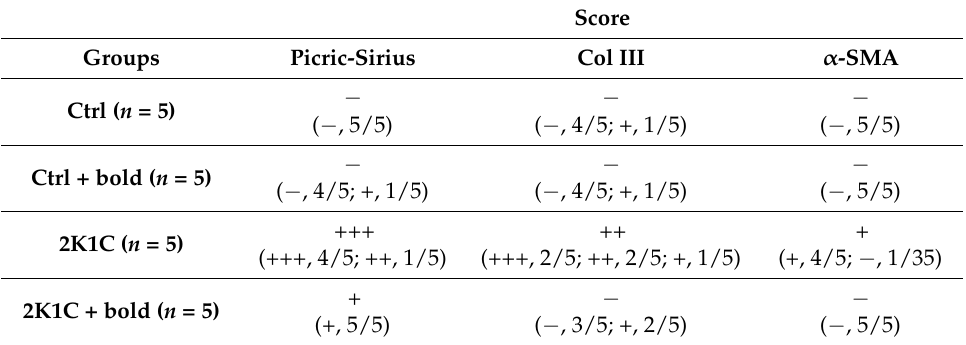
Table 2. Immunoreactivity score for Picric-Sirius, α -SMA, and Col III from tissue samples from rats of the four experimental groups. The semi-quantitative morphometric analysis for Picric-Sirius, α -SMA, and Col III was performed on a scale of negative to three crosses ( − to +++), defined according to the degree of immunoreactivity observed in the renal tissue sample ([ − ] = 0–10%, [+] = 10–40%, [++] = 40–70% and [+++] = 70–100%).